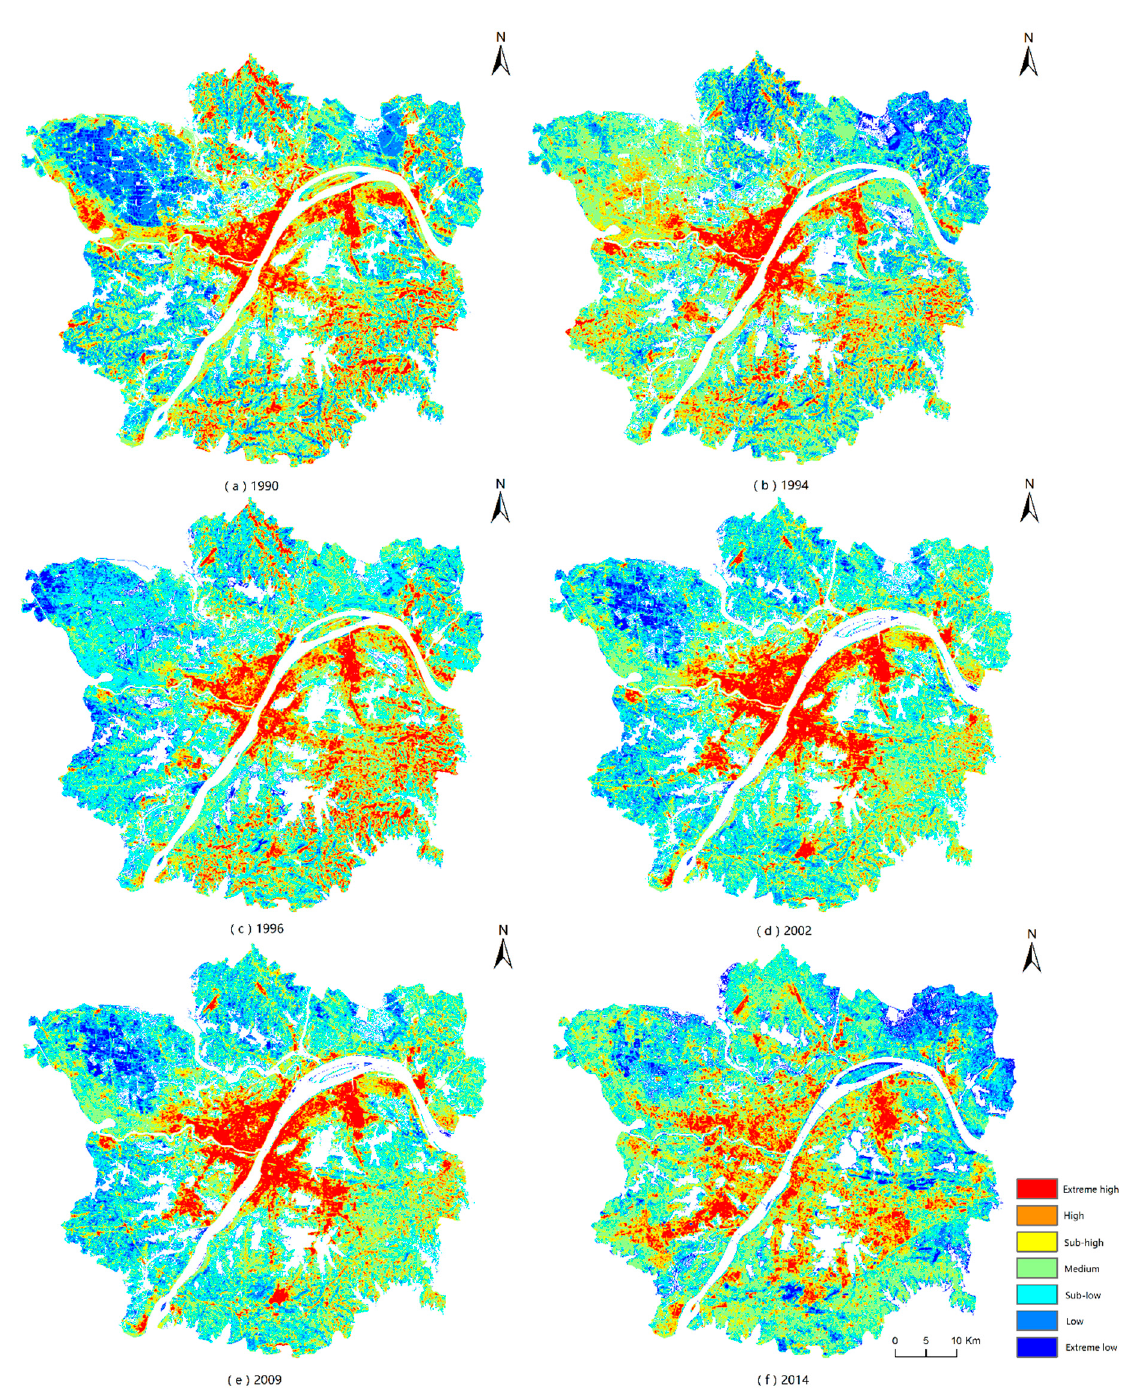
Figure 4 . The thematic thermal map of the experimental area. Figure 4. The thematic thermal map of the experimental